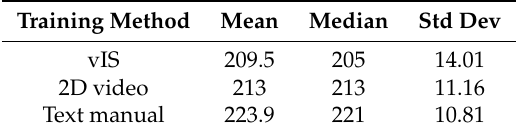
Table 3. Recall measurement time comparison of all three training methods (in